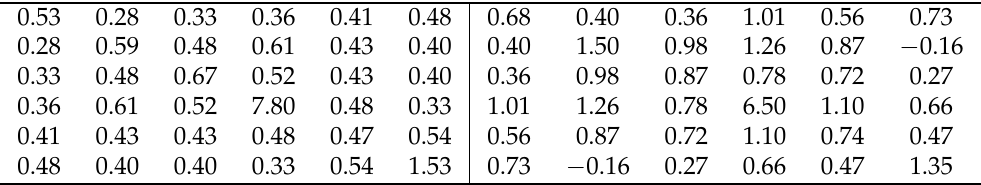
Table 4. Values of ˆ A ( E , m ) ( 0,1 ) ( m = 4 left, m = 1 right) obtained from the quarterly historical series TRI30496 over the period 1 January 2013 to 31 December 2017. Results are expressed in 10 − 2